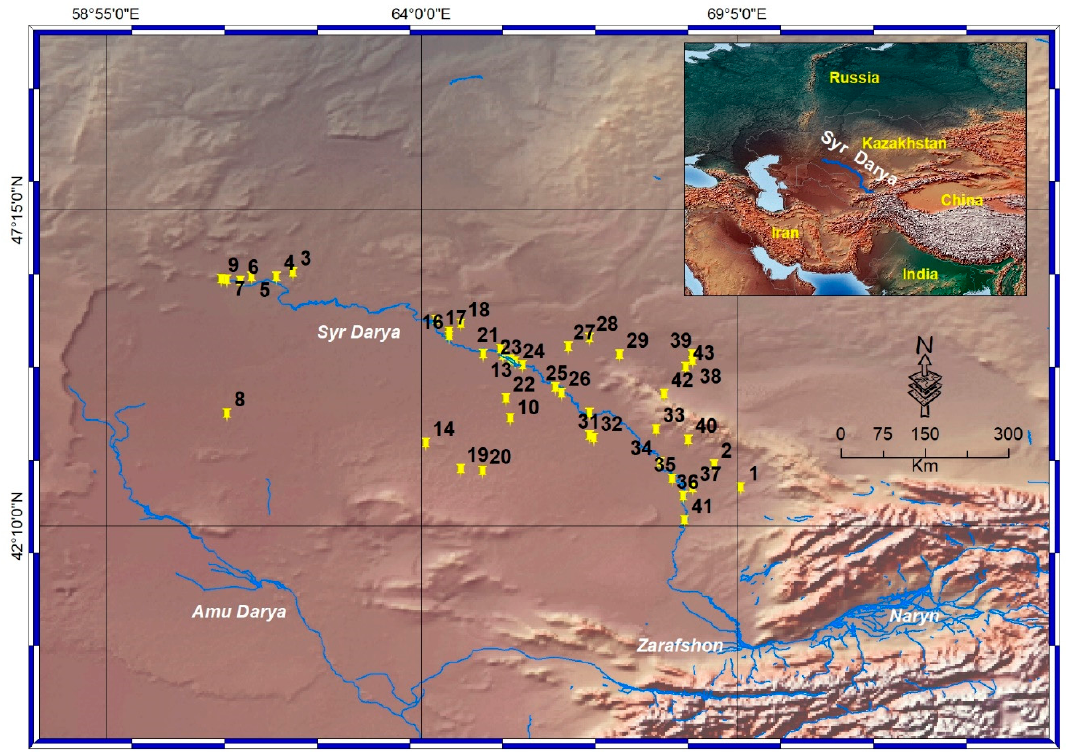
Figure 1. Study area and the location of the water samples (numbers close to the yellow pin). Source of the image: http://www.naturalearthdata.com.